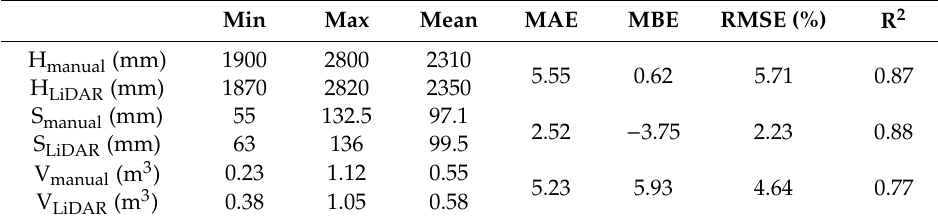
Table 4. Descriptive statistics of manual measurements of height (H manual ) (mm), stem